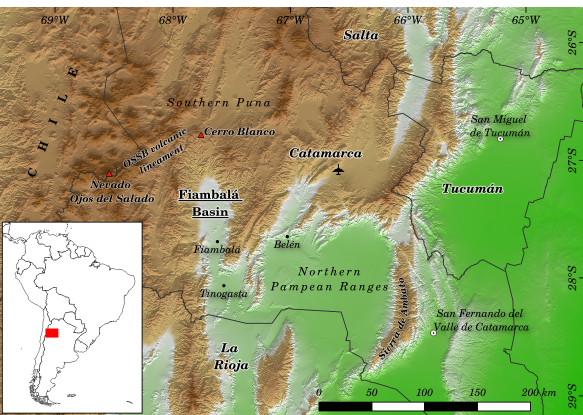
Figure 1. Map of NW Argentina showing the complex terrain en- vironment of the region under study. The Fiambalá Basin is an intermontane depression located in the proximity of the Ojos del Salado–San Buenaventura (OSSB) volcanic lineament, in a transi- tional region between the southern Puna plateau and the northern Pampean ranges. The triangles indicate the location of volcanoes mentioned in the text. The location of an automatic weather station at Catamarca Airport is shown south of San Fernando del Valle de